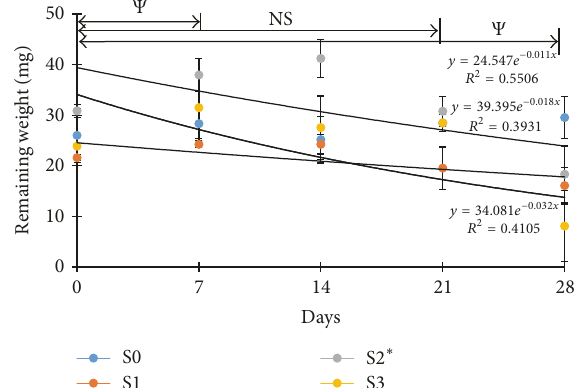
Figure 8: The inverse exponential of infused carrageenan 3D scaffolds remaining weight (mg) versus time of incubation (day). The experiments were carried out in triplicate ( 𝑛 = 3 ). ∗ Ψ ( 𝑝 < 0.05 ): significantly different as compared to S0. NS: not